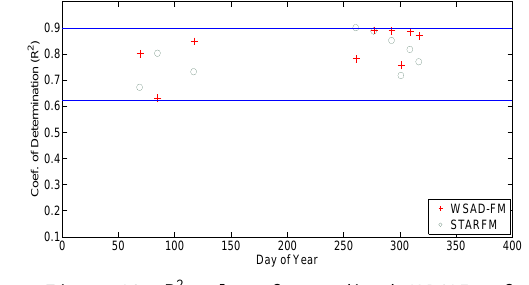
Figure 12. R 2 values for predicted NDVIs of Landsat images at time t p .